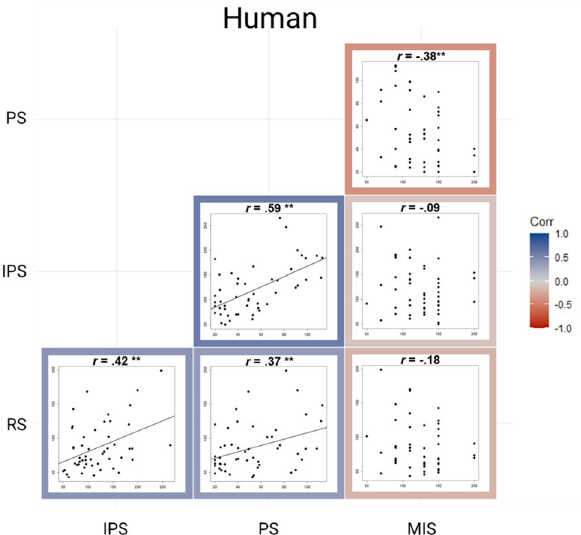
Figure 5. Correlation matrix plot showing the relation between the RS, IPS, PS and MIS when facing the virtual human. The r refers to the Spearman coefficient when the correlation includes MIS and to the Pearson coefficient when it does not. ** p -values < .001, * p -values <